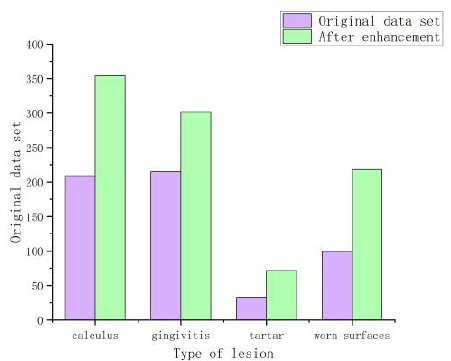
Figure 8. Comparison of the number of occurrences of each lesion on the original dataset and the combined combined dataset .